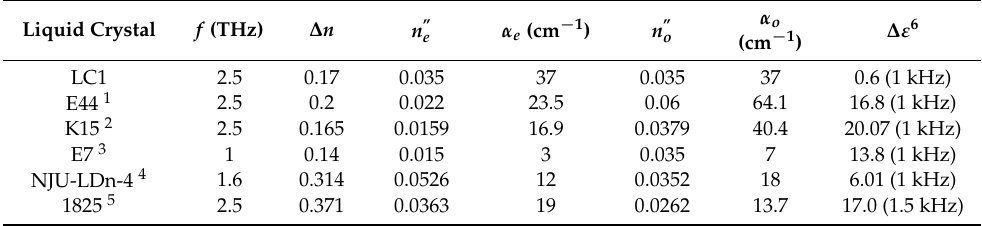
Table 1. Birefringence, absorption coefficients, and dielectric anisotropy of LC1. For comparison, reported values of various LCs are given.